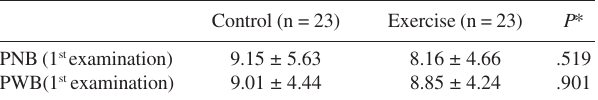
Table 4 - Perineometry results obtained for the 46 patients at the first examination (HCFMUSP, November 2003 to December 2004).